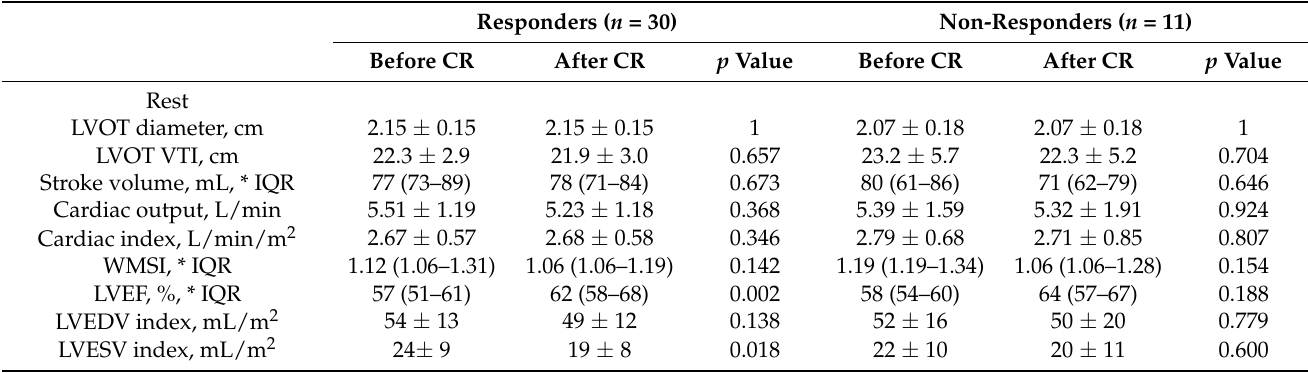
Table 3. Stress echocardiography parameters of study participants before and after cardiac rehabilitation. Responders ( n =